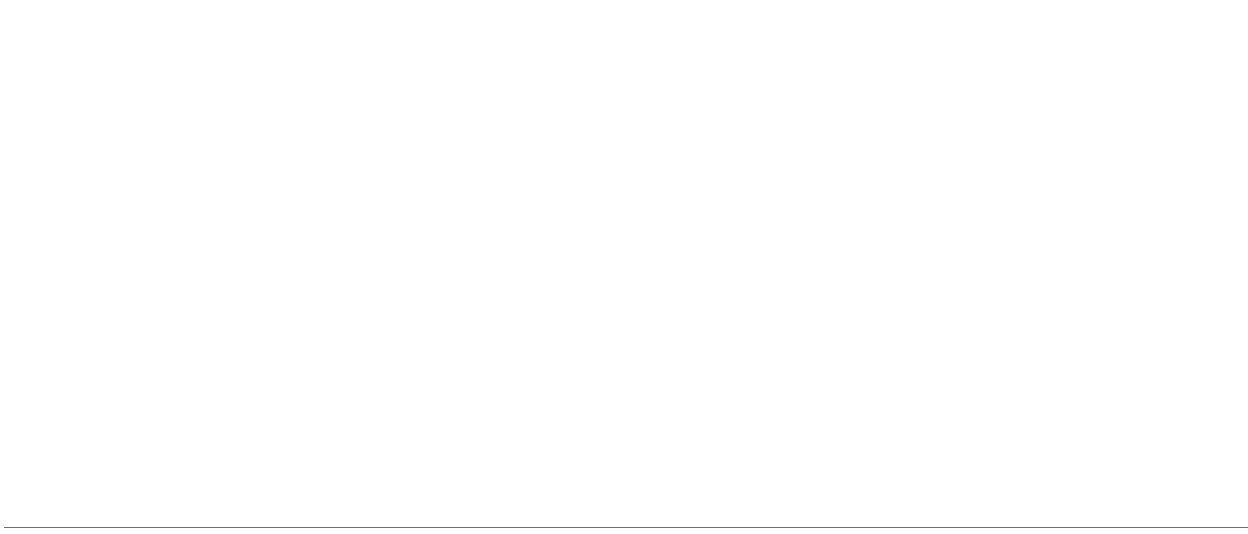
Frontiers in Materials |